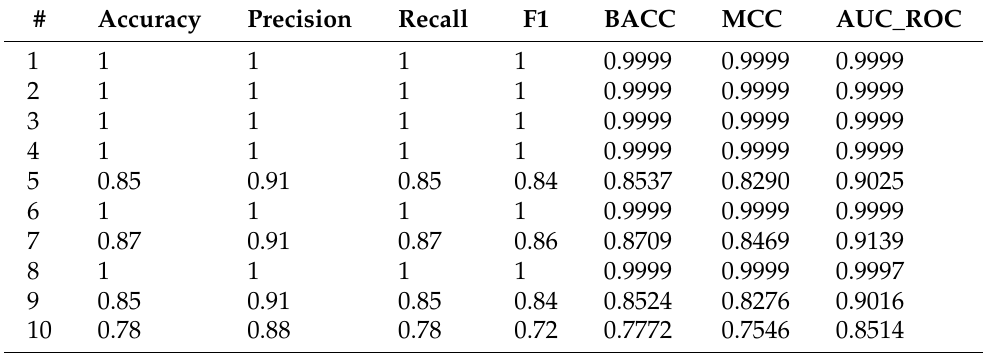
Table 8. Summary of the results for the Random Forest Classifier.